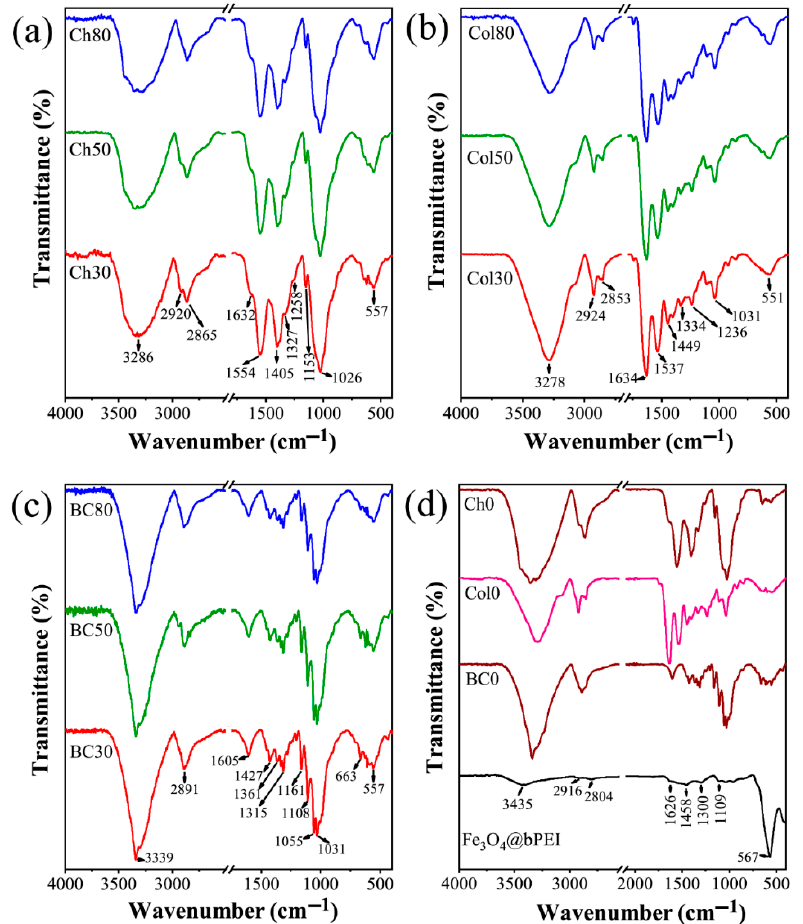
Figure 3. Fourier Transform Infrared Spectroscopy (FTIR) spectra of ( a ) Chitosan films; ( b ) Collagen films; ( c ) Bacterial cellulose films; and ( d ) Pure components of biocomposite films.